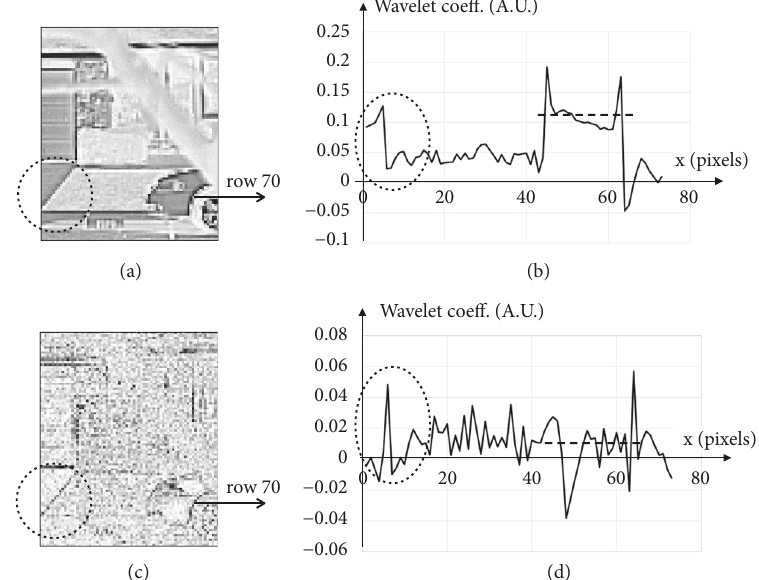
Figure 7: Waveletcoefficientsof source image (picture and graph on the top) and normalized image (on the bottom): modulus of the wavelet coefficients in (a), (c); the wavelet coefficients along the row 70 in (b), (d).